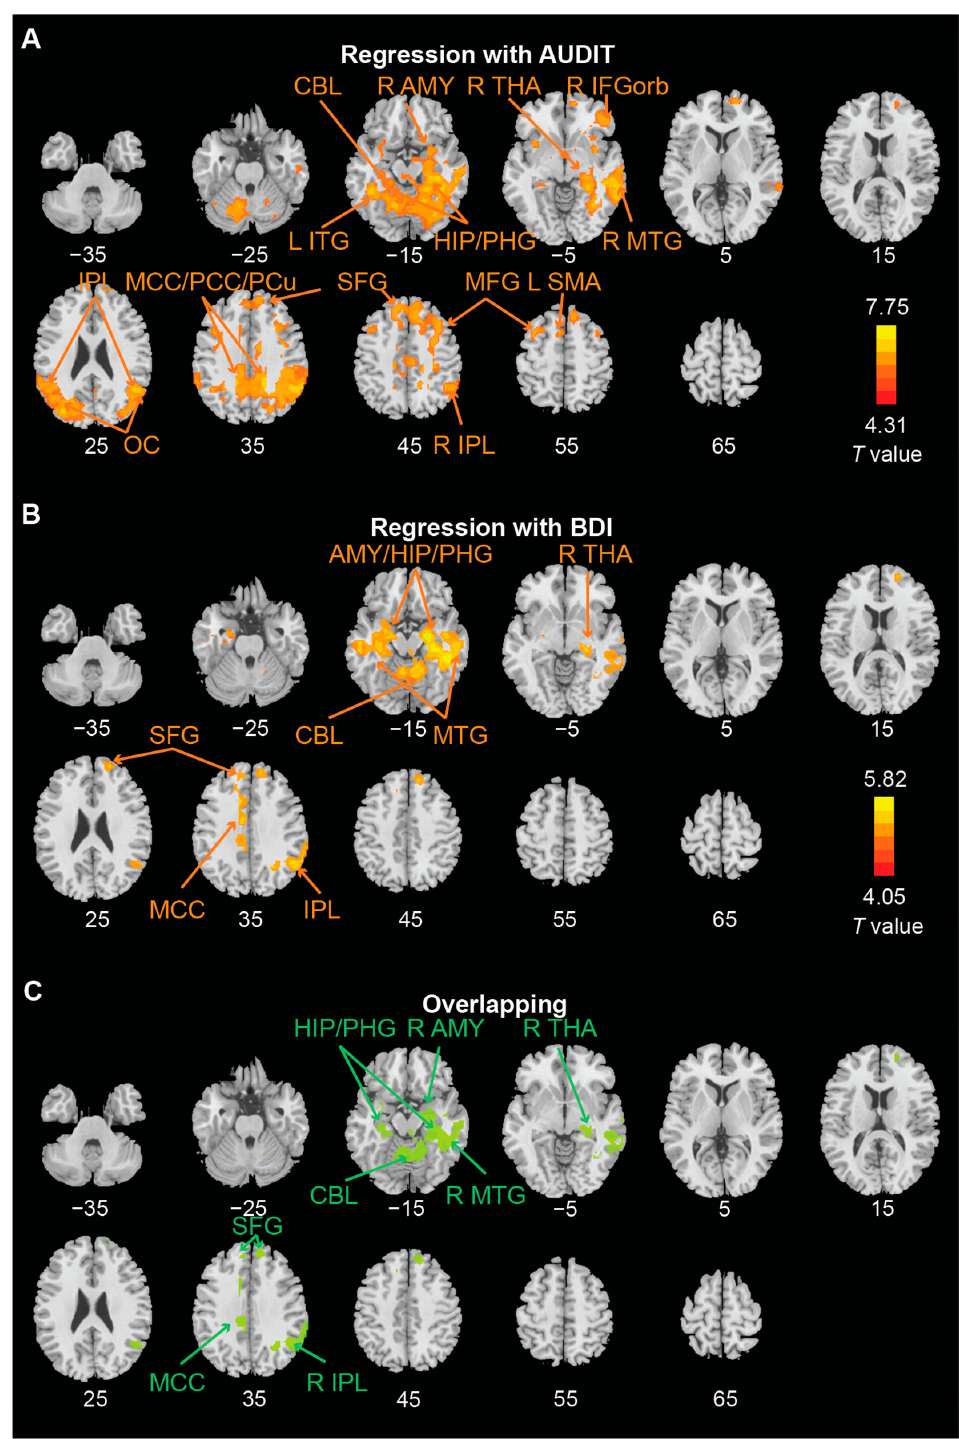
Figure 4. Regional activations to loss vs. nil in correlation with ( A ) AUDIT and ( B ) BDI-II score with age, sex, and FTND score as covariates at voxel p < 0.001 in combination with cluster-level p < 0.05 FWE corrected. The brain regions are summarized in Table 2. ( C ) ROIs overlapped of ( A , B ). L: left; R: right; AMY: amygdala; CBL: cerebellum; IFGorb: inferior frontal gyrus pars orbitalis; HIP: hippocam- pus; IPL: inferior parietal lobule; ITG: inferior temporal gyrus; MCC: mid-cingulate cortex; MFG: middle frontal gyrus; MTG: middle temporal gyrus; OC: occipital cortex; PHG: parahippocampal gyrus; SFG: superior frontal gyrus; SMA: supplementary motor area; THA: